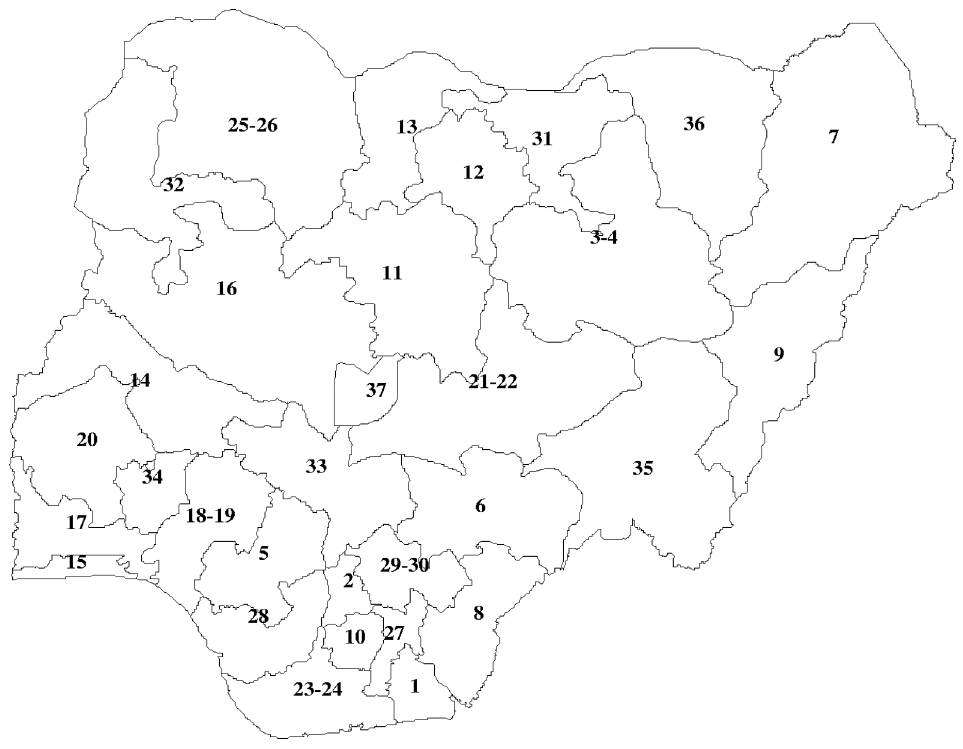
Figure 1. Map of Nigeria by states. 1, Akwa Ibom. 2, Anambra. 3, Bauchi. 4, Gombe. 5, Edo. 6, Benue. 7, Borno. 8, Cross-River. 9, Adamawa. 10, Imo. 11, Kaduna. 12, Kano. 13, Katsina. 14, Kwara. 15, Lagos. 16, Niger. 17, Ogun. 18, Ondo. 19, Ekiti. 20, Oyo. 21, Nassarawa. 22, Plateau. 23, Bayelsa. 24, Rivers. 25, Sokoto. 26, Zamfara. 27, Abia. 28, Delta. 29, Ebonyi. 30, Enugu. 31, Jigawa. 32, Kebbi. 33, Kogi. 34, Osun. 35, Taraba. 36, Yobe. 37, Abuja.